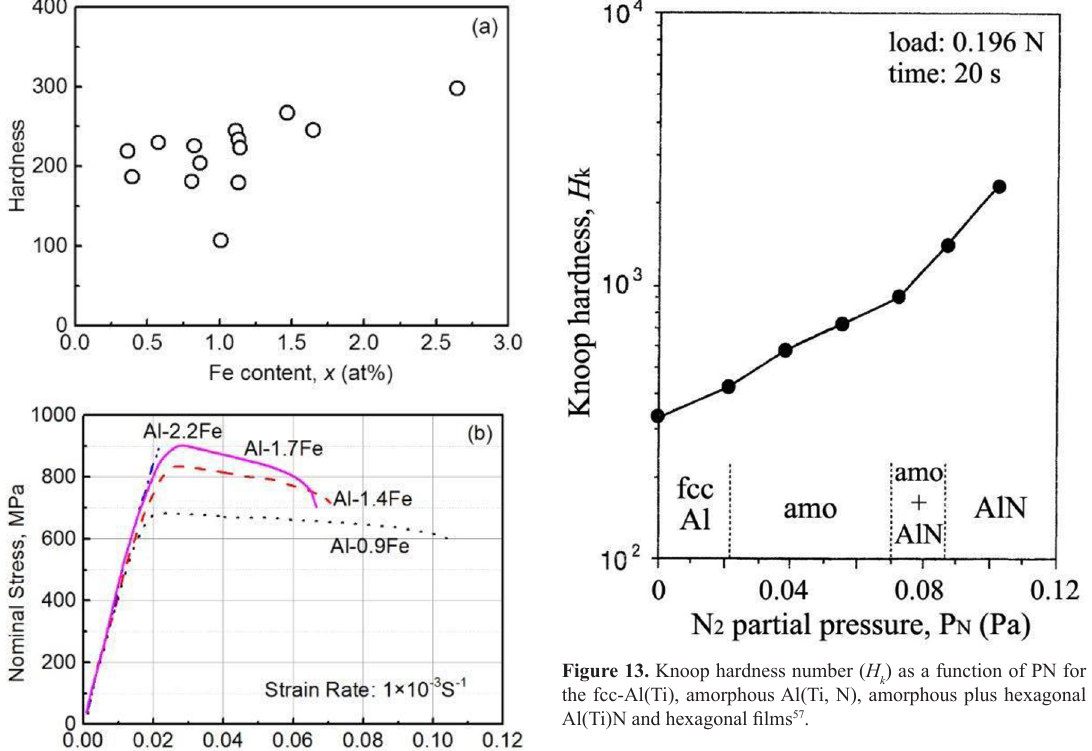
) as a function of PN for k